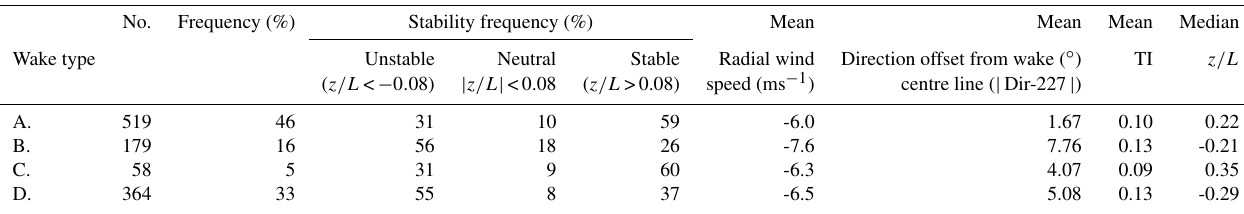
Figure 7. Example of radial wind speed anomalies at the six downstream distances, 2, 2.5, 3, 3.5, 4 and 4.5 D , from the arc scans on 5 May 2017 at 23:48 (UTC; the data used to construct the anomalies are as shown in Fig. 6). Points indicate the measurement locations, while the background shading is a cubic spline interpolation of the anomalies (shown only to aid visual interpretation). The black open circle denotes the first guess location of the wake centre line from the previous “slice” or in the first panel from the inflow conditions. The magenta circle shows the centre location as identified by the tracking algorithm. To aid in identifying the location of this circle a vertical line is shown that the bisects this location. Table 2. External conditions from 78m height at Tower 20 calculated for subjective classification of wake types. There are 1971 wake cases in total, with 1120 having meteorological data